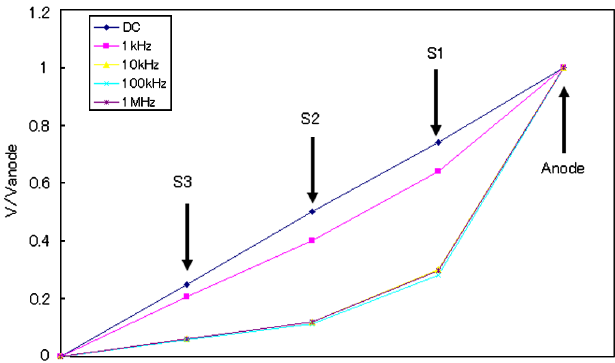
FIG. 20. Voltages measured at the anode and subsidiary elec- trodes S1, S2, and S3 (normalized by the anode